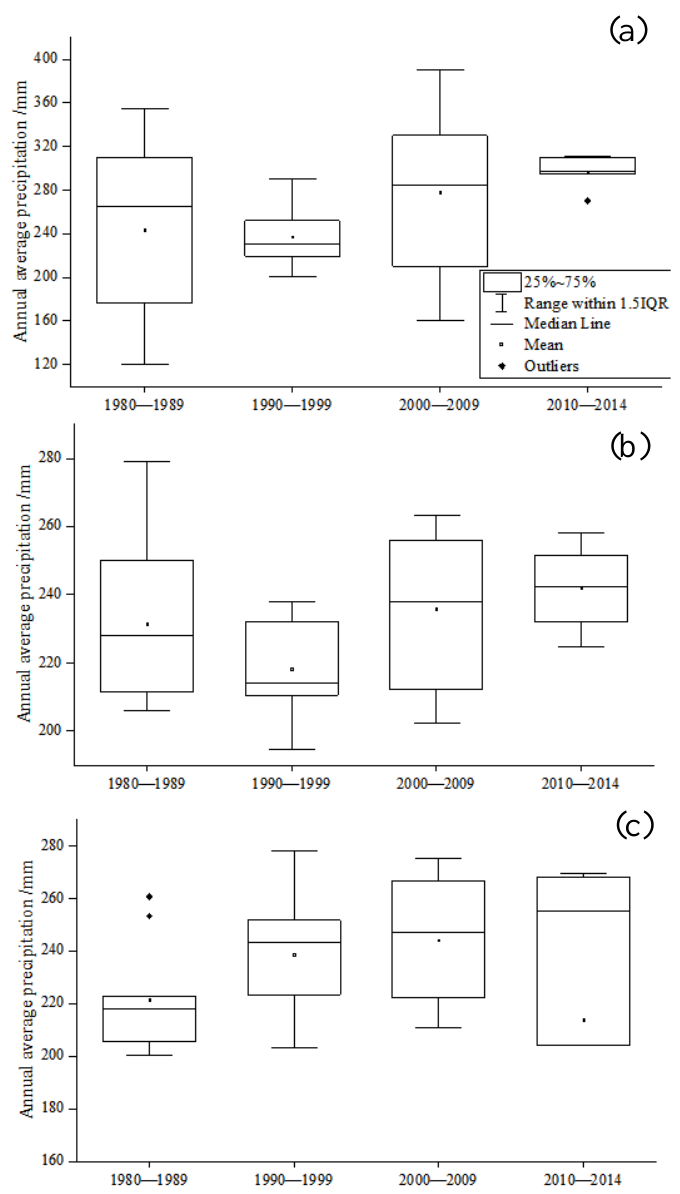
Figure 10. Annual average precipitation comparison from 1980 to 2014 ( a ): annual average precipita- tion of equal weight set simulated by CMIP6 model. ( b ): the annual average precipitation corrected by the correction methods based on the EOF. ( c ): annual average precipitation of observa- tion).